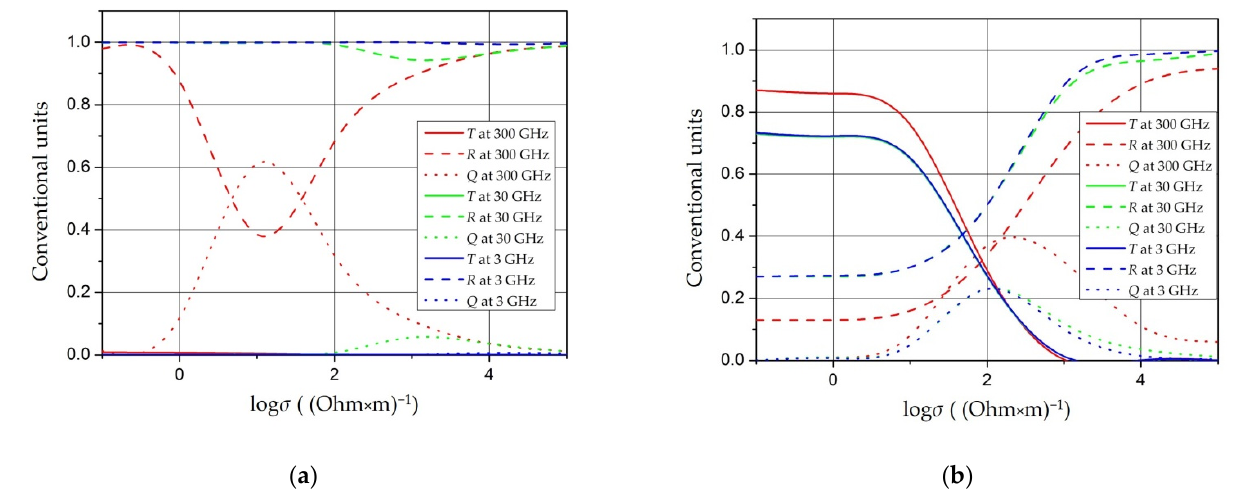
Figure 36. The dependences of the reflection R , transmission T , and absorption Q coefficients on the electrical conductivity of the composite layer on ( a ) metal substrate with electrical conductivity σ m = 10 7 (Ohm × m) − 1 and ( b ) ceramic substrate with ε c = 10 at the different incident radiation frequencies of 300 GHz (dashed line), 30 GHz (solid line), and 3 GHz (dotted line). The dependences of the reflection coefficients R (solid line) and absorption coefficients Q (dotted line) on the composite layer thickness d are presented in Figure 37. The composite layers with σ = 5 (Ohm × m) − 1 (solid line) and σ = 200 (Ohm × m) − 1 (dotted line) were placed on a Cu substrate without (a) or with intermediate dielectric ( ε = 50) layer with thicknesses (b) 5 mm or (c) 10 mm.